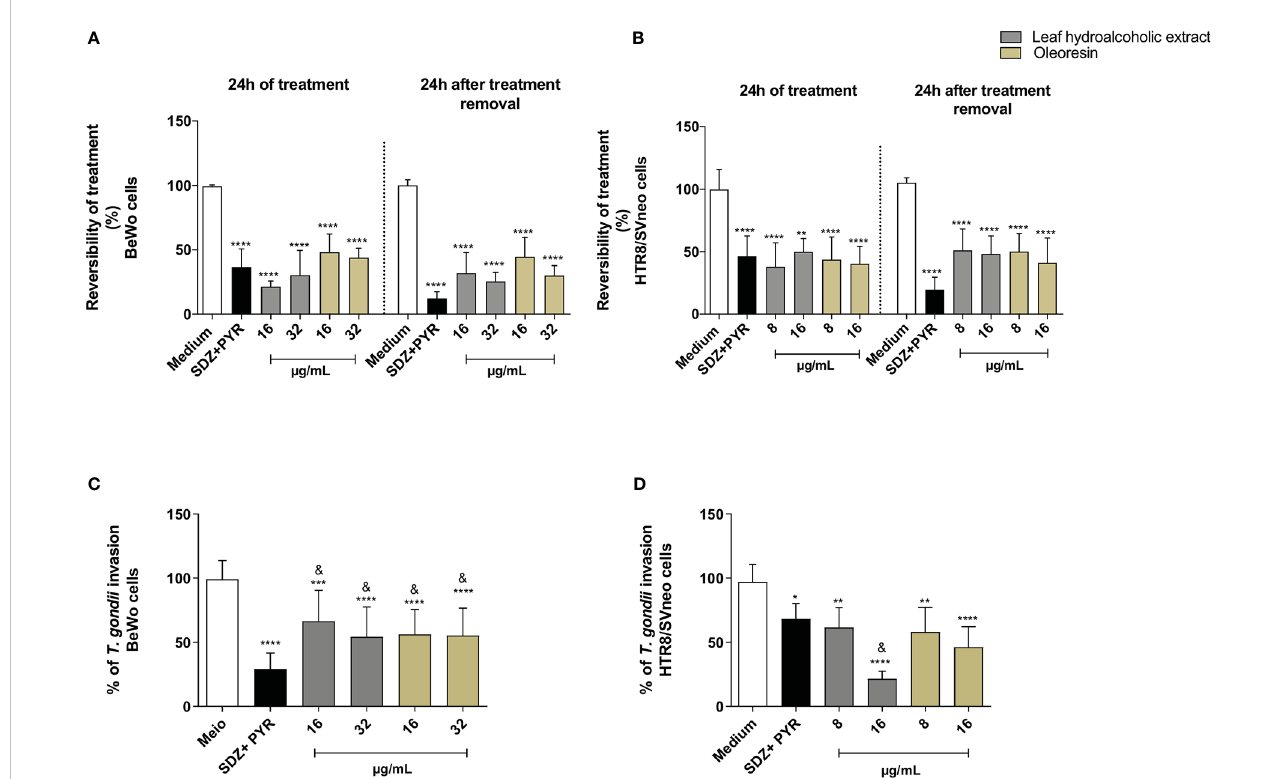
FIGURE 3 Reversibility test. BeWo (A) and HTR8/SVneo (B) cells were infected by T. gondii and treated or not with non-toxic concentrations of the hydroalcoholic extract or oleoresin from C. multijuga for 24 h. In parallel, both cells were infected, treated, washed to remove the treatments, and maintained for additional 24 h in the medium free of treatment. Untreated and infected cells (medium) were considered as 100% reversibility of treatment, and SDZ + PYR was used as positive control. T. gondii intracellular proliferation was analyzed using a b -galactosidase colorimetric assay and expressed as percentage (reversibility of treatment) in comparison to untreated cells (medium). The reversibility index measured the ability of parasites to recover from treatment and proliferate in new cells. Finally, parasites obtained directly from BeWo (C) and HTR8/SVneo (D) cells treated with the